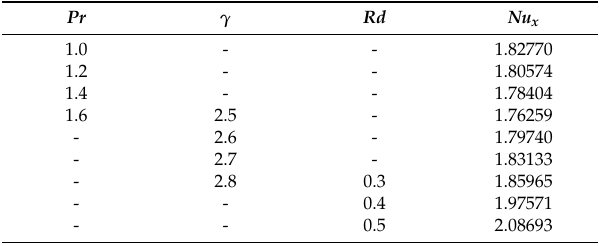
(cid:16) (cid:17) Rd G (cid:48) ( 0 ) , when A = 0.5, Ψ = 1 at time instant 1 + 4 3